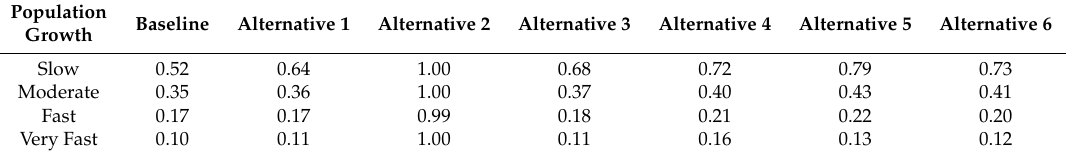
Table 7. Fraction of the water demand delivered.